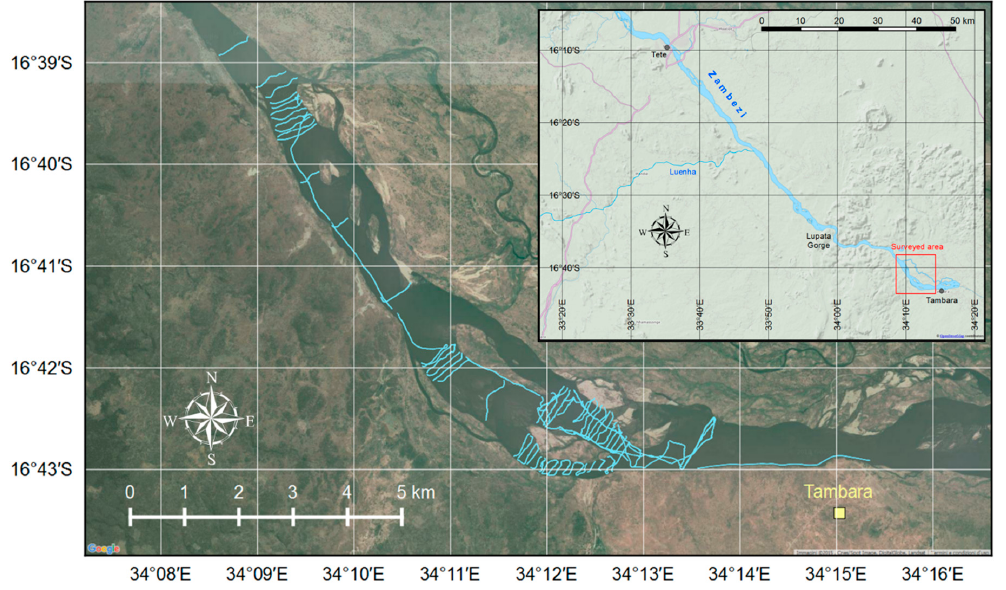
Figure 5. Overview of the investigated area and map of survey data.